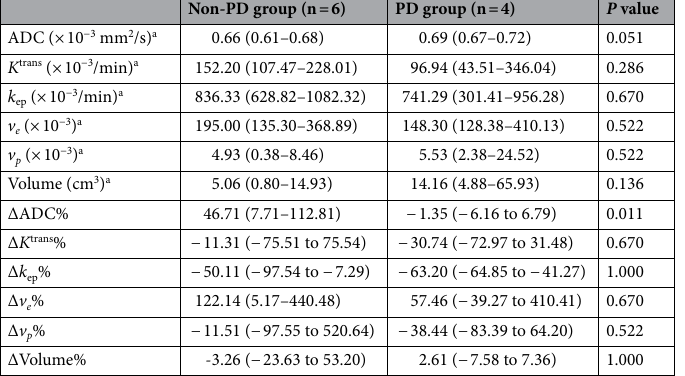
Table 4. Comparison of MRI parameters between the non-PD and PD groups. Numbers are medians and ranges in parentheses. MRI, magnetic resonance imaging; ADC, apparent diffusion coefficient, K trans , volume transfer constant; k ep , rate constant; PD, progressive disease; v e , volume fraction of the extravascular extracellular matrix; v p , blood plasma volume. a Data from baseline MRI.